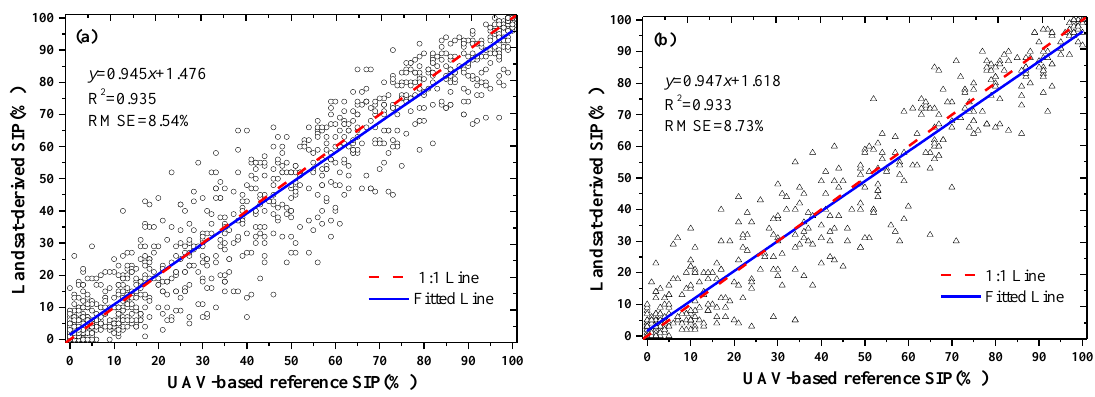
Figure 10. The R 2 and RMSE of the relationships between the reference and Landsat-predicted SIP using RT in 2014 for the: training data ( a ); and validation data ( b ). The red dotted lines are the 1:1 lines, and the blue solid lines are linear regressions between the predicted and UAV-based reference SIP.